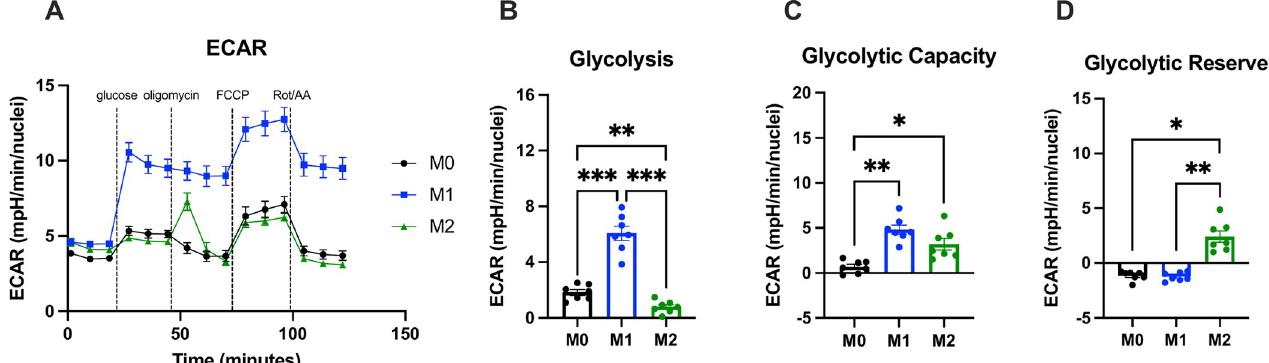
Fig 2. hMDM polarization induces changes in glycolysis. hMDM ECAR (A) was measured using Seahorse Extracellular Flux. M1 hMDMs were significantly more glycolytic (B) than other polarization states, and both M1 and M2 hMDMs had significantly higher glycolytic capacity (C) than M0 like hMDMs. M2 hMDMs had significantly more glycolytic reserve than M0 or M1 hMDMs (D). n = 7 biological replicates (3 males, 4 females) with 3–4 technical replicates per biological replicate and polarization state. Data are presented as mean ± SEM. � p < 0.05, �� p < 0.01, ��� p < 0.001 by matched one-way ANOVA with Tukey’s multiple comparisons test (B,C) or Friedman test with Dunn’s multiple comparisons test (D).